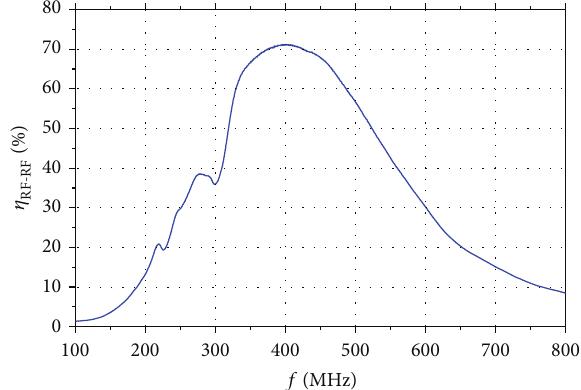
Figure 8: Experimental results obtained for the power transfer ) of the proposed wireless energy efficiency ( 𝜂 RF-RF